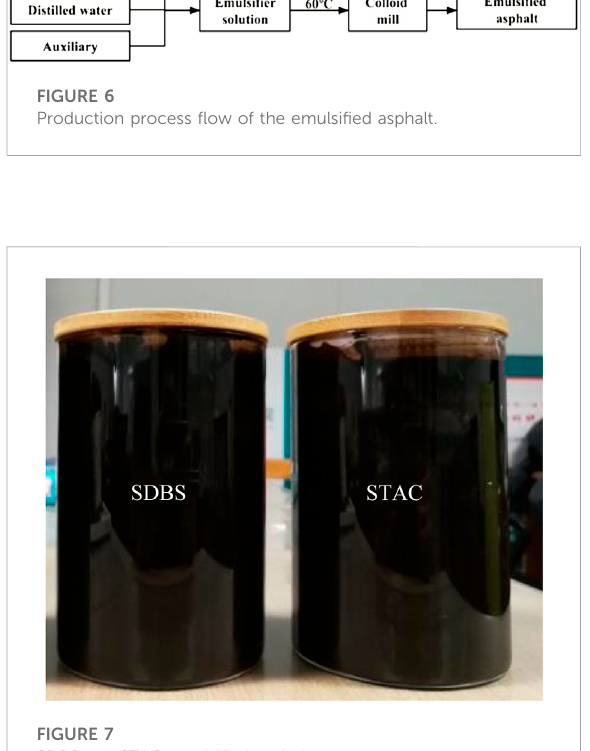
FIGURE 7 SDBS and STAC emulsi fi ed asphalts.